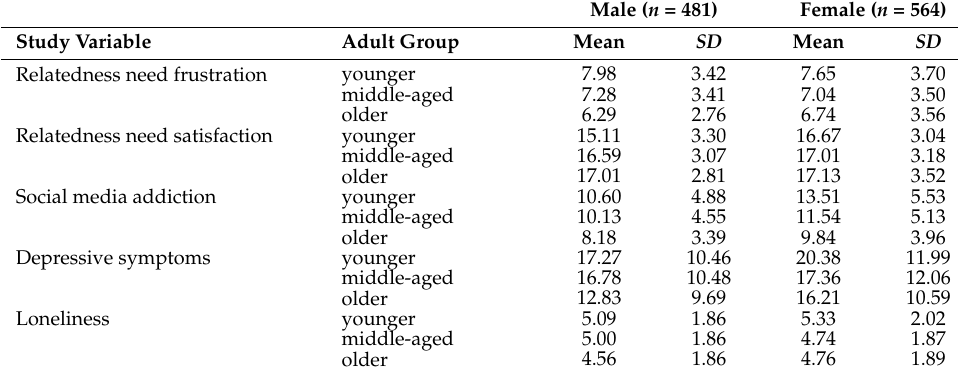
Table 1. Descriptive statistics of study variables by sex and age groups.